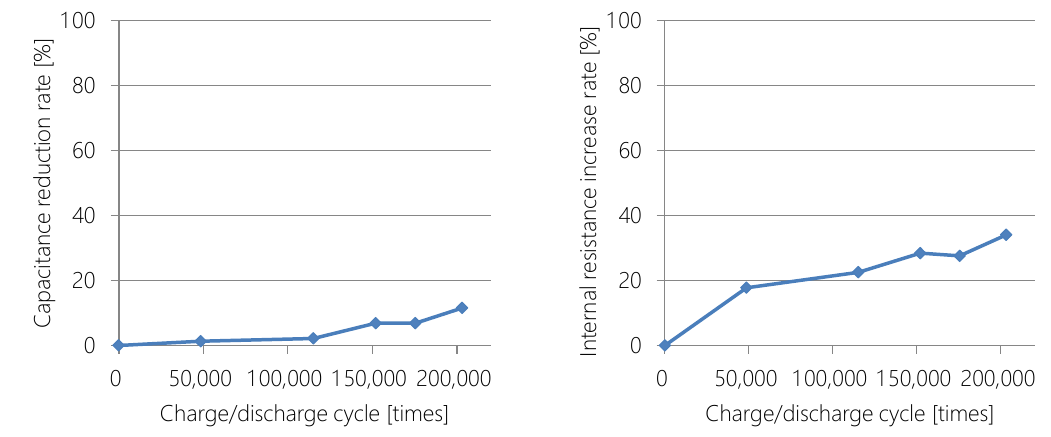
Figure 13. Test result of charge–discharge test at low temperature.